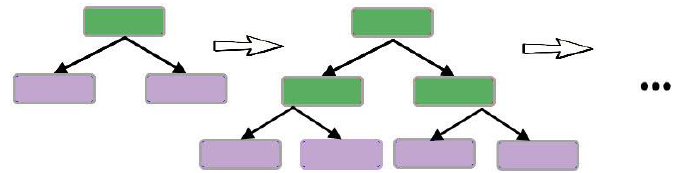
Figure 5. Schematic diagram of XGBoost classifier.